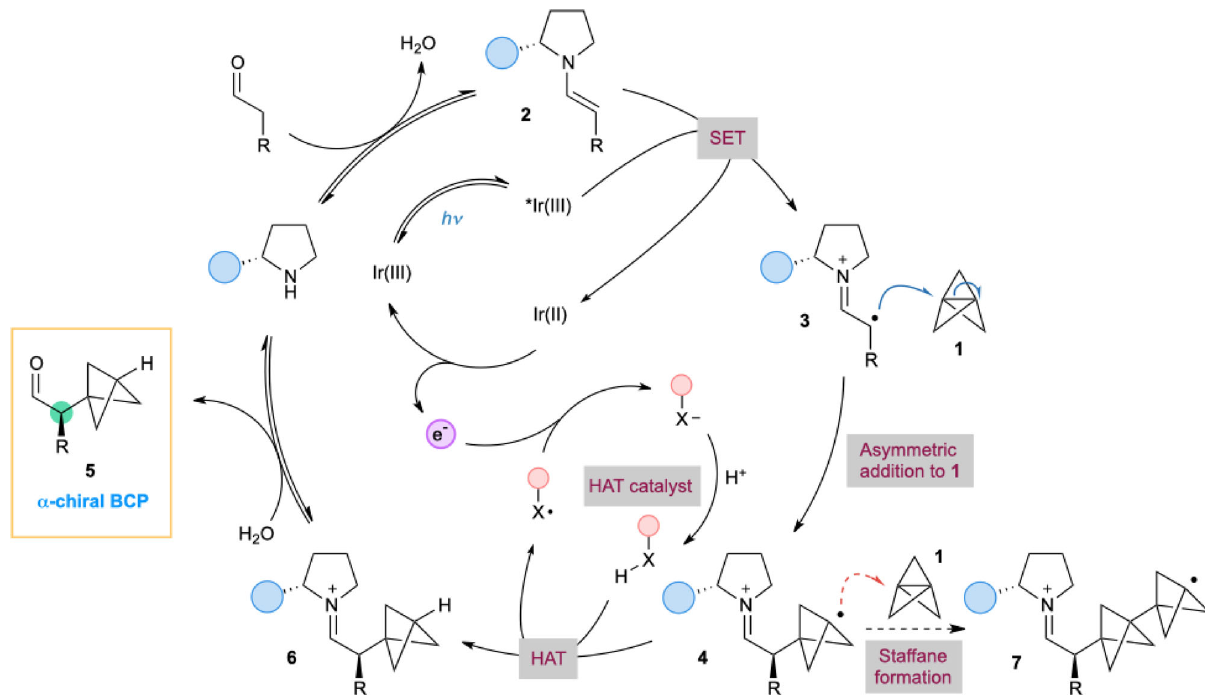
Fig. 2 Design of a multicatalytic direct asymmetric radical addition to [1.1.1]propellane (1). Potential side reactions include staffane formation by addition of radical 4 to 1 , and reaction of the HAT catalyst with 1